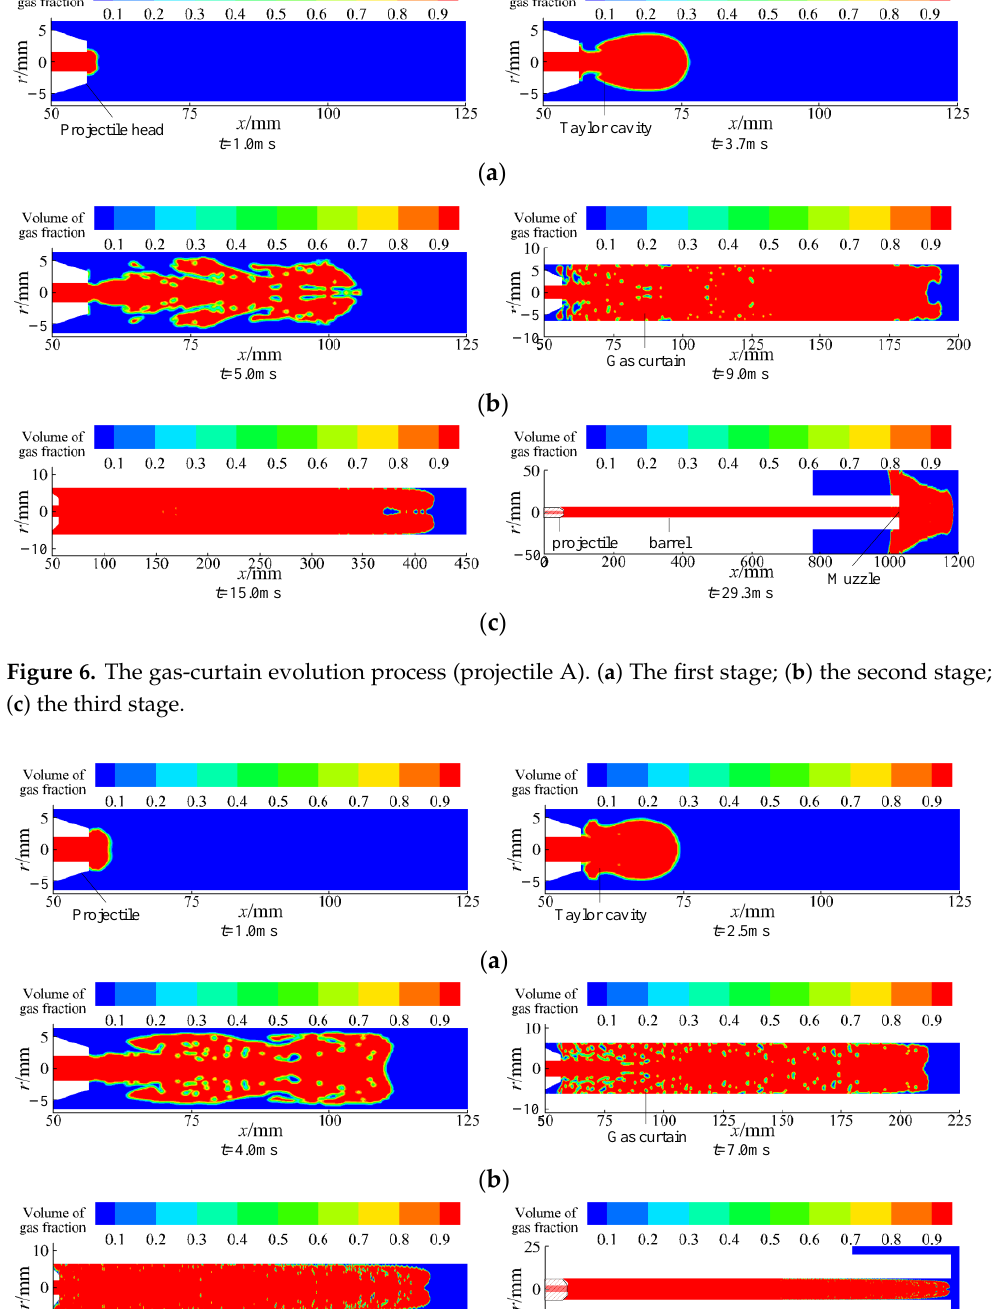
( f ) Figure 5. Interior ballistics curves of gas-curtain launcher under three jet structures; ( a ) p-t ; ( b ) p-l ; ( c ) v-t ; ( d ) v-l ; ( e ) p h -t ; ( f ) p h -l . It is obvious that jet structure within a gas-curtain projectile has an important influ- ence on the drag reduction and propulsion performance of an underwater launcher. 3.3. Gas-Curtain Evolution Characteristics The influence of jet structure on drag reduction effect and interior ballistics charac- teristics is mainly reflected in the evolution characteristics of the gas-curtain. Therefore, the evolution characteristics of the gas-curtain before projectile start-up are analyzed. Moreover, the gas-curtain can be separated into three stages according to its evolution process, namely, the Taylor cavity expansion stage (the first stage), the gas-curtain for-